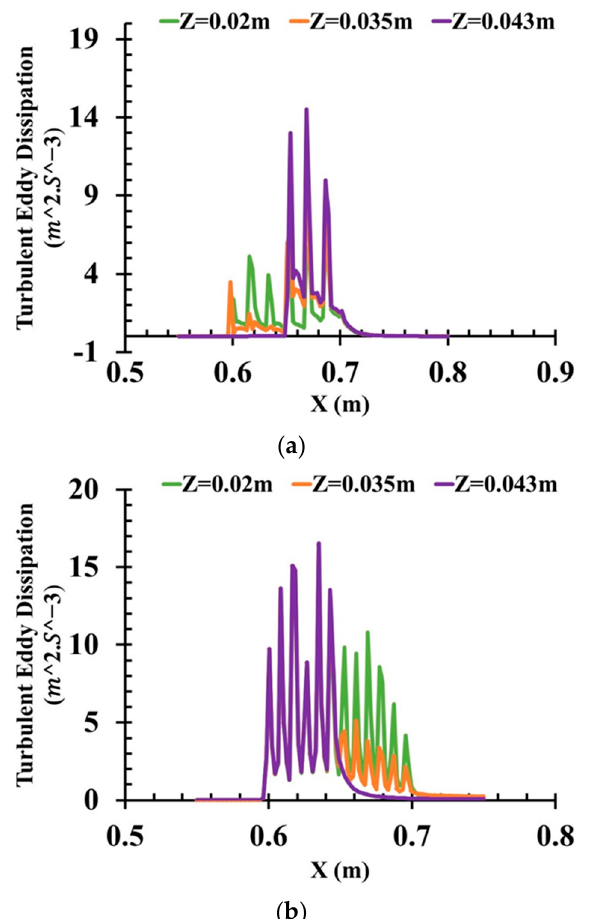
Figure 13. Longitudinal distribution of turbulence eddy dissipation rate: ( a ) case 1; ( b ) case 3.